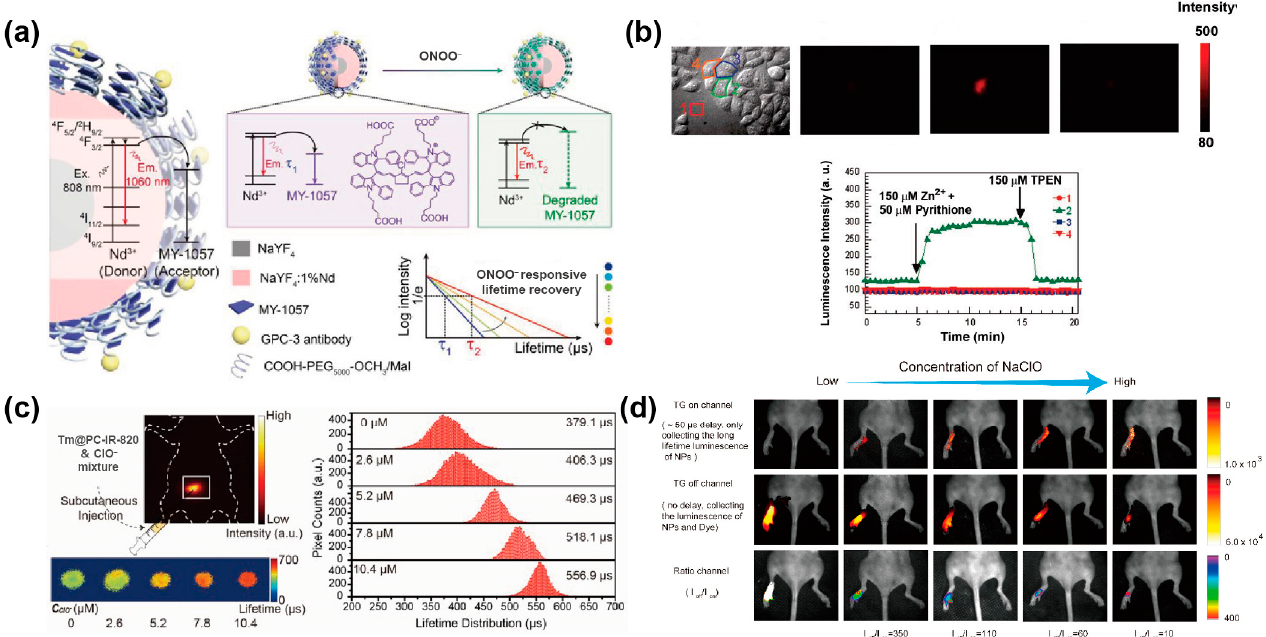
Figure 7. ( a ) Schematic diagram of nanosensor DSNP@MY-1057-GPC responding to ONOO − . Re- produced with permission from [69]. Copyright 2020, WILEY-VCH. ( b ) Time-resolved luminescence imaging of Zn 2+ in living HeLa cells. Reproduced with permission from [71]. Copyright 2007, American Chemical Society. ( c ) Simulated luminescence lifetime imaging of the detection of responsive ClO − . Reproduced with permission from [55]. Copyright 2019, WILEY-VCH. ( d ) The images of living mice in vivo with injection of 25 μ L sodium hypochlorite solution and 25 μ L NaYF 4 :Nd@Cy860@PC aqueous solution (3 mol/L). Reproduced with permission from [72]. Copy- right 2019, American Chemical Society.